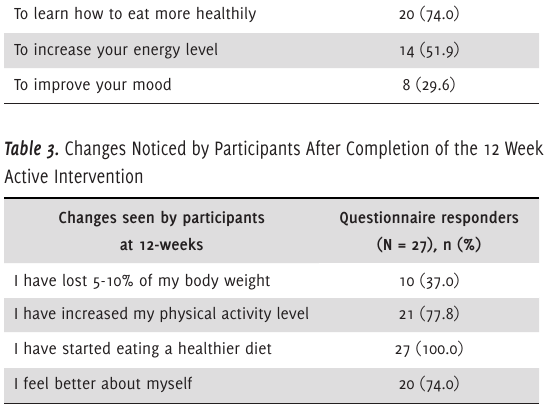
Diagram illustrating the distribution of participants across intervention and control groups, and proportion that completed both the intervention and the Program Questionnaire across two sites in London and Sarnia Ontario, Canada. Completed INTERVENTION was defined as participants who attended at least six sessions (50%), including at least one session in the final six